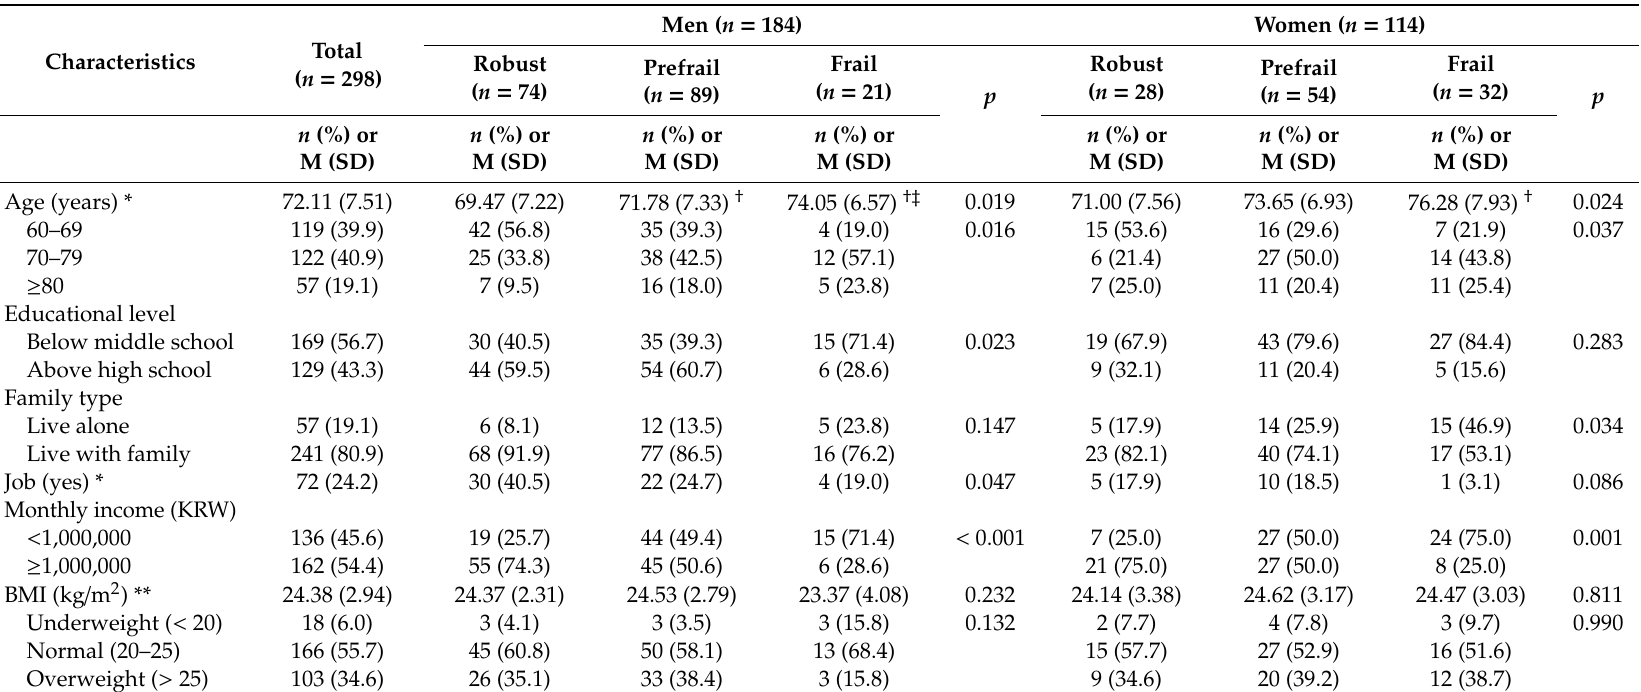
Table 1. Sociodemographic characteristics by gender and frailty status ( n =